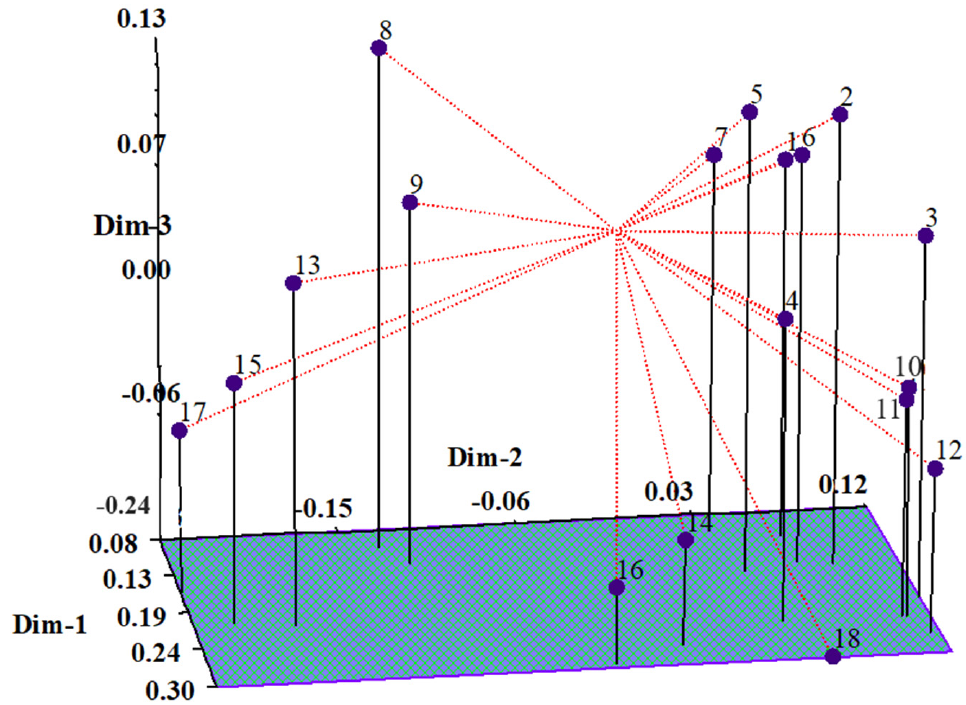
Figure 3. PCA (Principal Components Analysis) three − dimensional plot for 18 parsley genotypes using 181 iPBS markers.